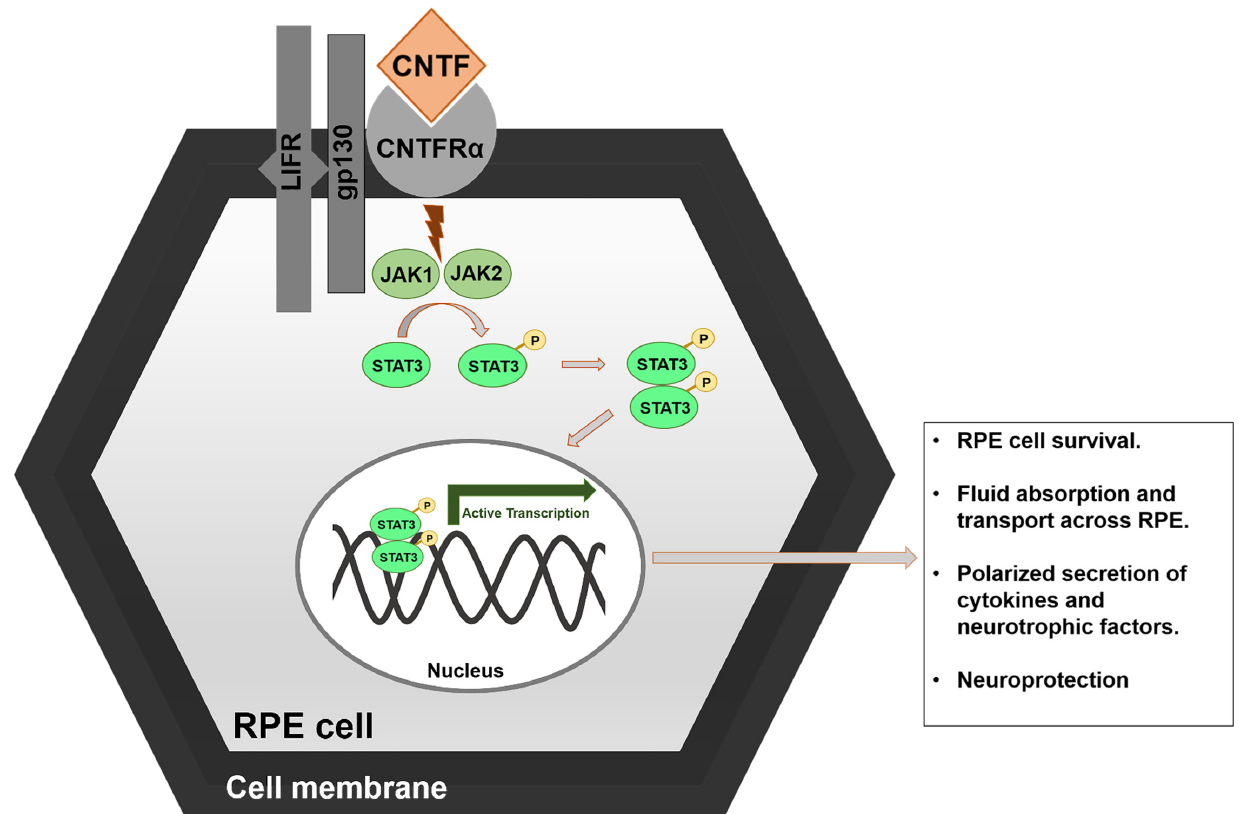
Figure 3. Ciliary NeuroTrophic Factor (CNTF)’s mechanism of action. CNTF binds to a trimeric receptor complex comprised of CNTFR α , gp130, and LIFR leading to its activation. Active CNTF results in phosphorylation of STAT3 which then activates transcription of target genes in the nucleus. This leads to RPE cell survival, fluid absorption and transport across the RPE, polarized secretion of cytokines and neutrophic factors, and subsequent